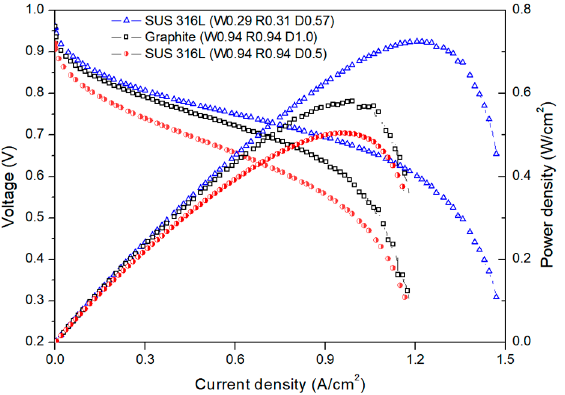
Figure 11. i-V curve in the 40th cycle of three types of BPs: SUS 316L (W0.29, R0.31, and D0.57), graphite (W0.94, R0.94, and D1.0), and SUS 316L (W0.94, R0.94, and D0.5).